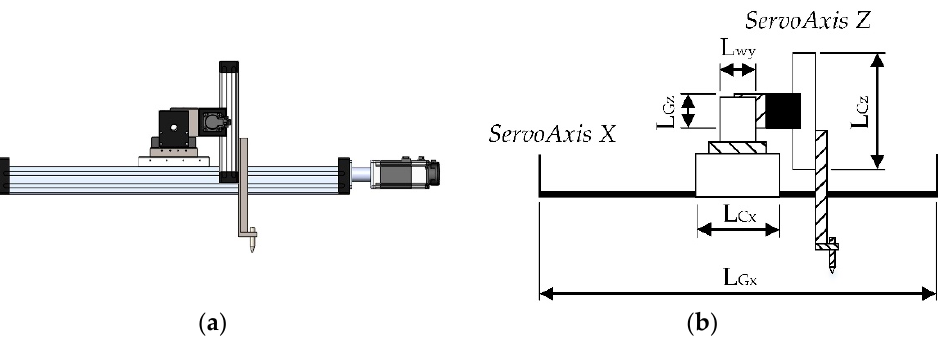
Figure 12. Side view. ( a ) 3D Version. ( b ) MMCS equivalent version.